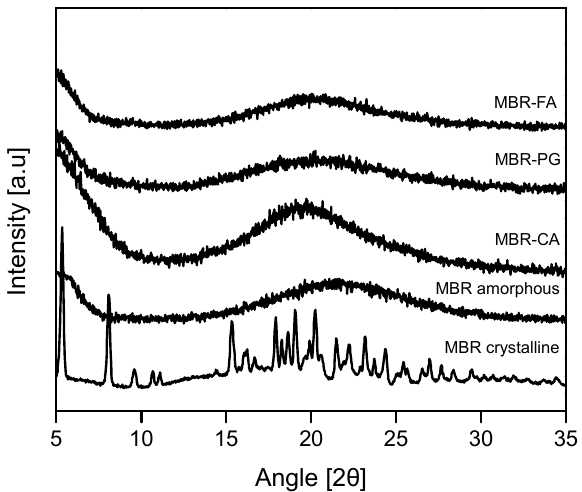
Figure 2. Powder X-ray diffraction (PXRD) patterns for MBR co-amorphouses (MBR-FA, MBR-PG, and MBR-CA), MBR amorphous and MBR crystalline.